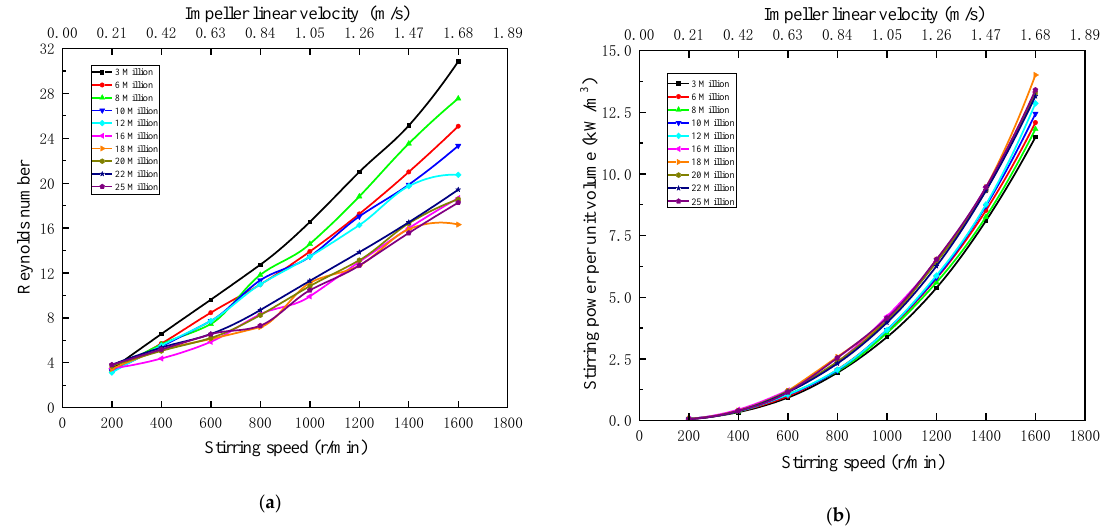
Figure 3. ( a ) Reynolds number versus stirring speed; ( b ) Stirring power per unit volume versus stirring speed.